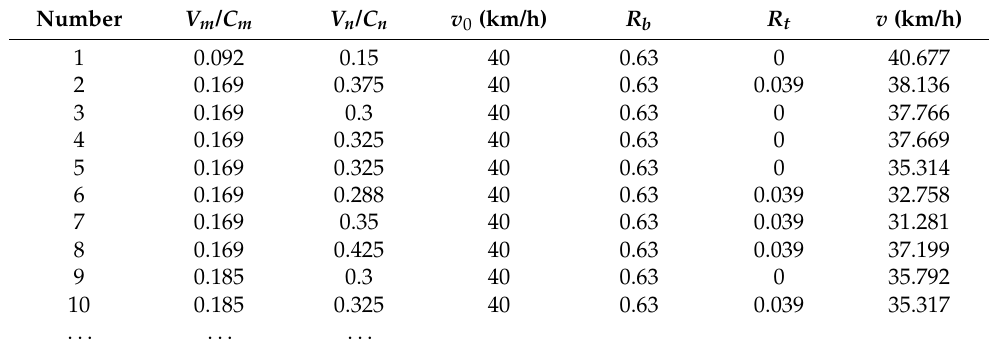
Table A3. BPR model parameters during roadside parking in scenario B1